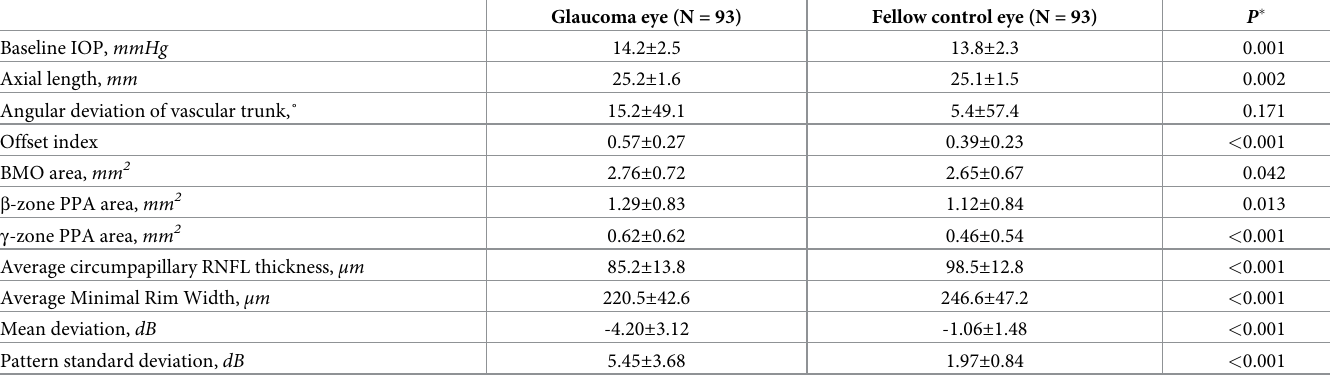
Table 1. Demographic comparison between glaucoma and fellow control eyes.